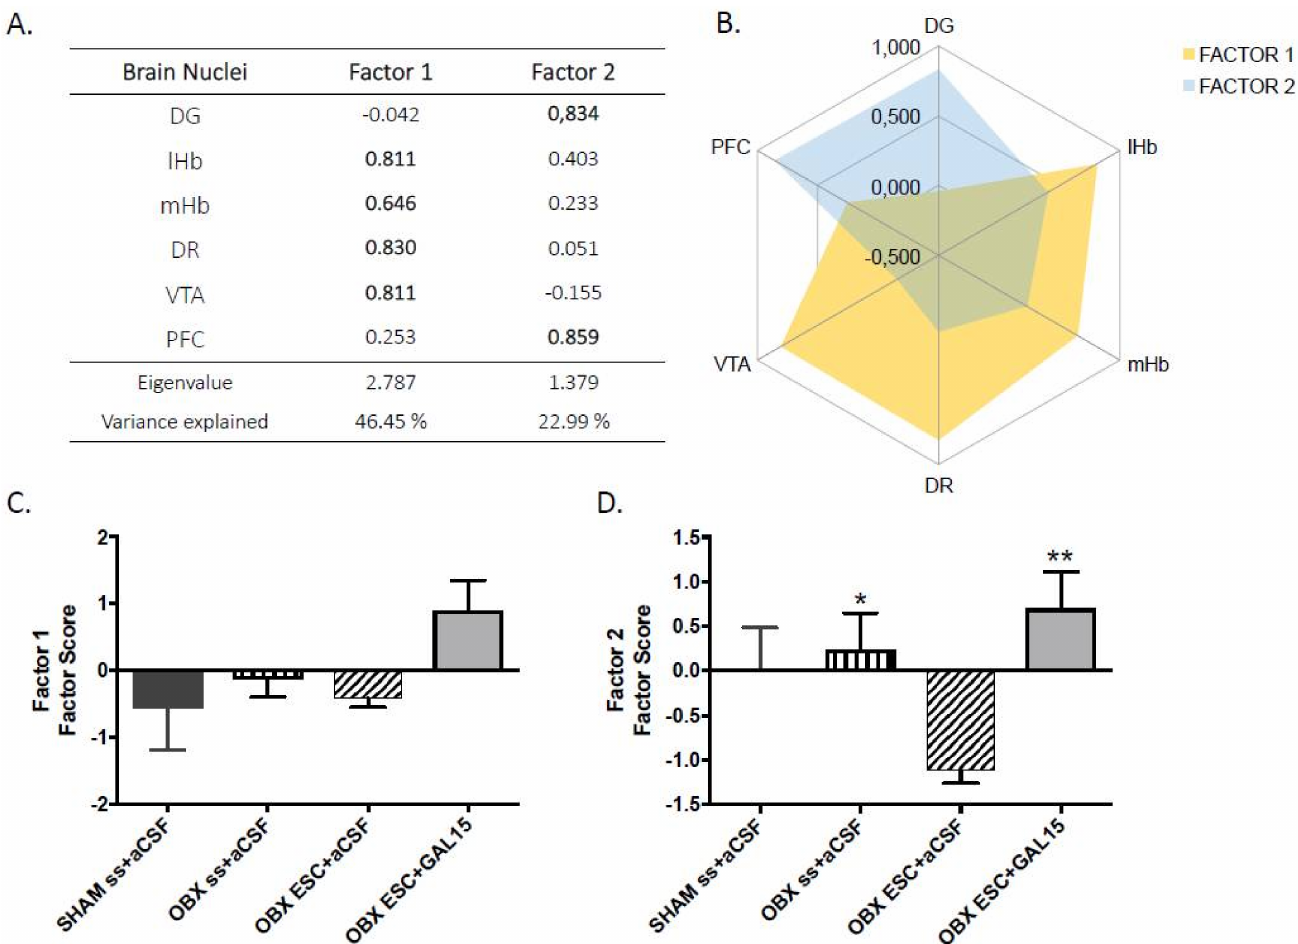
Figure 5. General regions extracted in principal component analyses. ( A ) The PCA of the number of c-Fos positive nuclei in a brain nucleus of revealed two independent dimensions (factors): Factor 1 and Factor 2. ( B ) Factor 1 was obtained from measures registered in habenula lateral (LHb), habenula medial (mHb), ventral tegmental area (VTA), and dorsal raphe (DR). Factor 2 was obtained from measures registered in dentate gyrus (DG) and prefrontal cortes (PFC). A brain nucleus was considered to be included in a factor when its loading was > 0.5 in absolute value (highlighted in bold). ( C , D ) Data represent the mean of the factor scores of the subjects in each one of the networks ± SEM of Factor 1 and 2 in SHAM SS+aCSF, OBX SS+aCSF, OBX ESC10 mg+aCSF, and OBX ESC10 mg+GAL(1-15)(1 nmol) (n = 4–5 rats per group). In Factor 1 there are no significant differences according to one way ANOVA followed by Fisher multiple comparison test. In Factor 2 * p < 0.05 versus OBX SS+aCSF and ** p < 0.01 versus OBX ESC10mg+aCSF according to one way ANOVA followed by Fisher multiple comparison